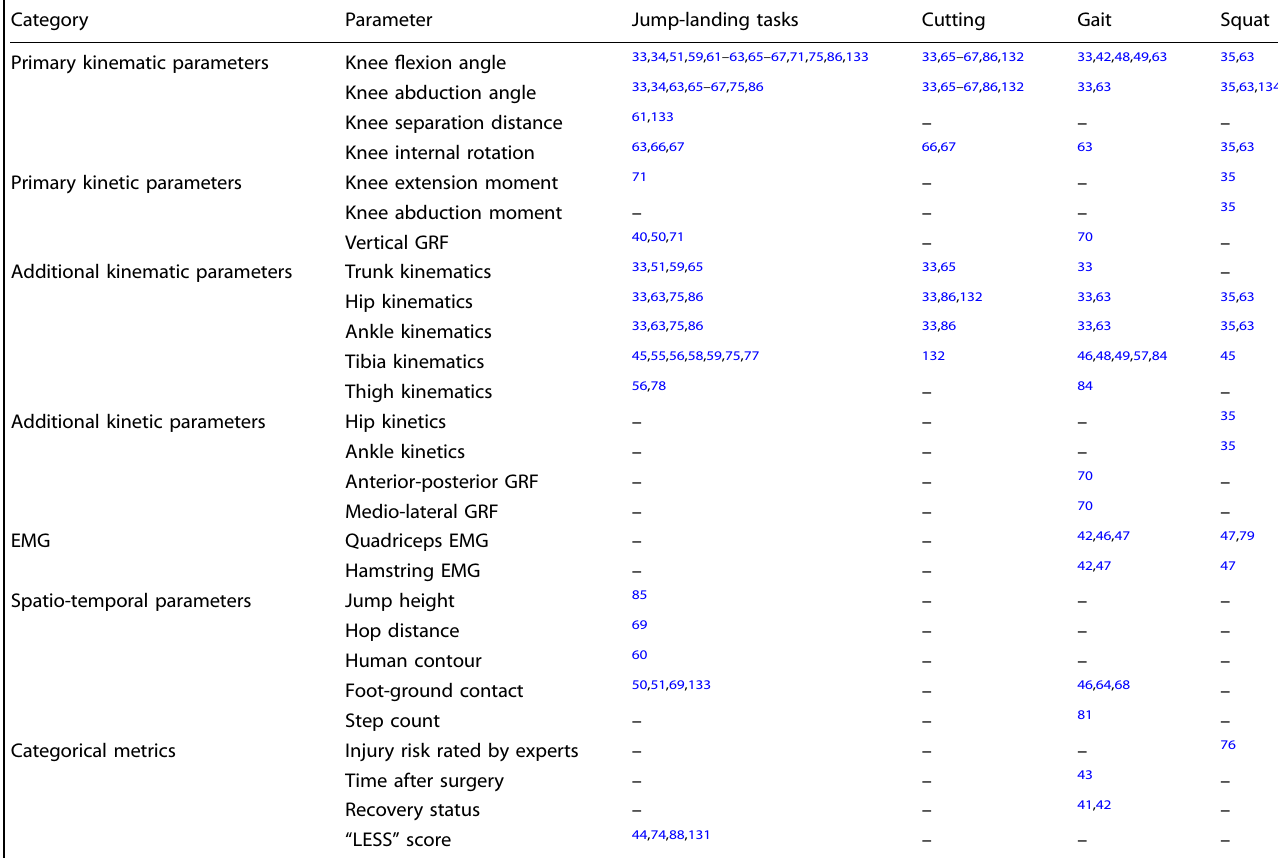
Table 2. Target motions and biomechanical parameters of included